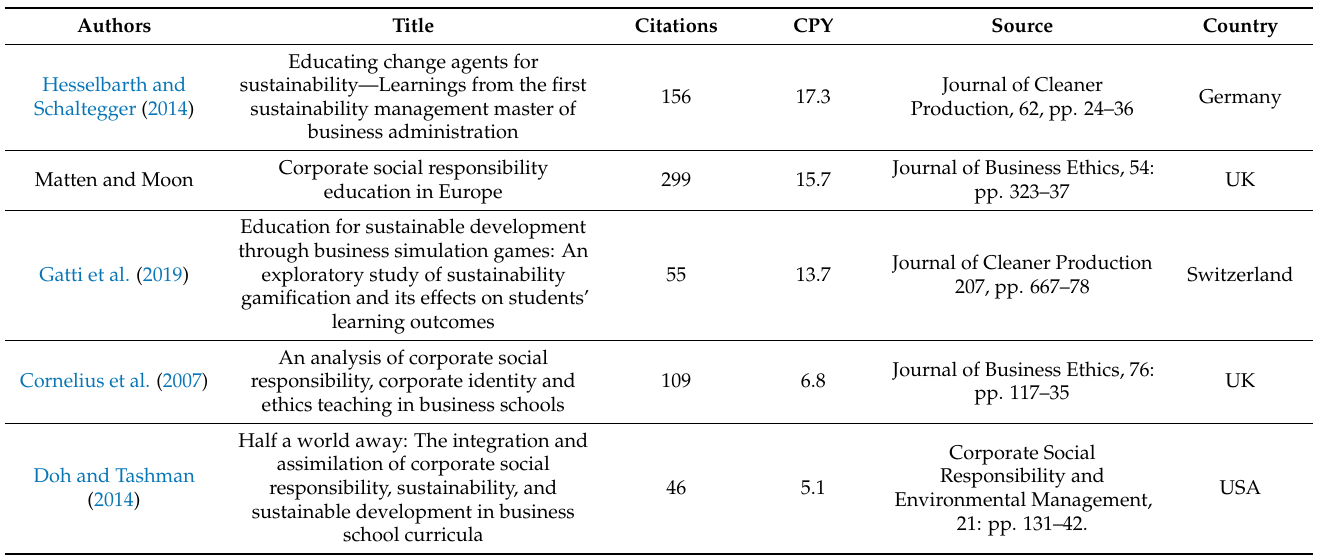
Table 5. Top five cited